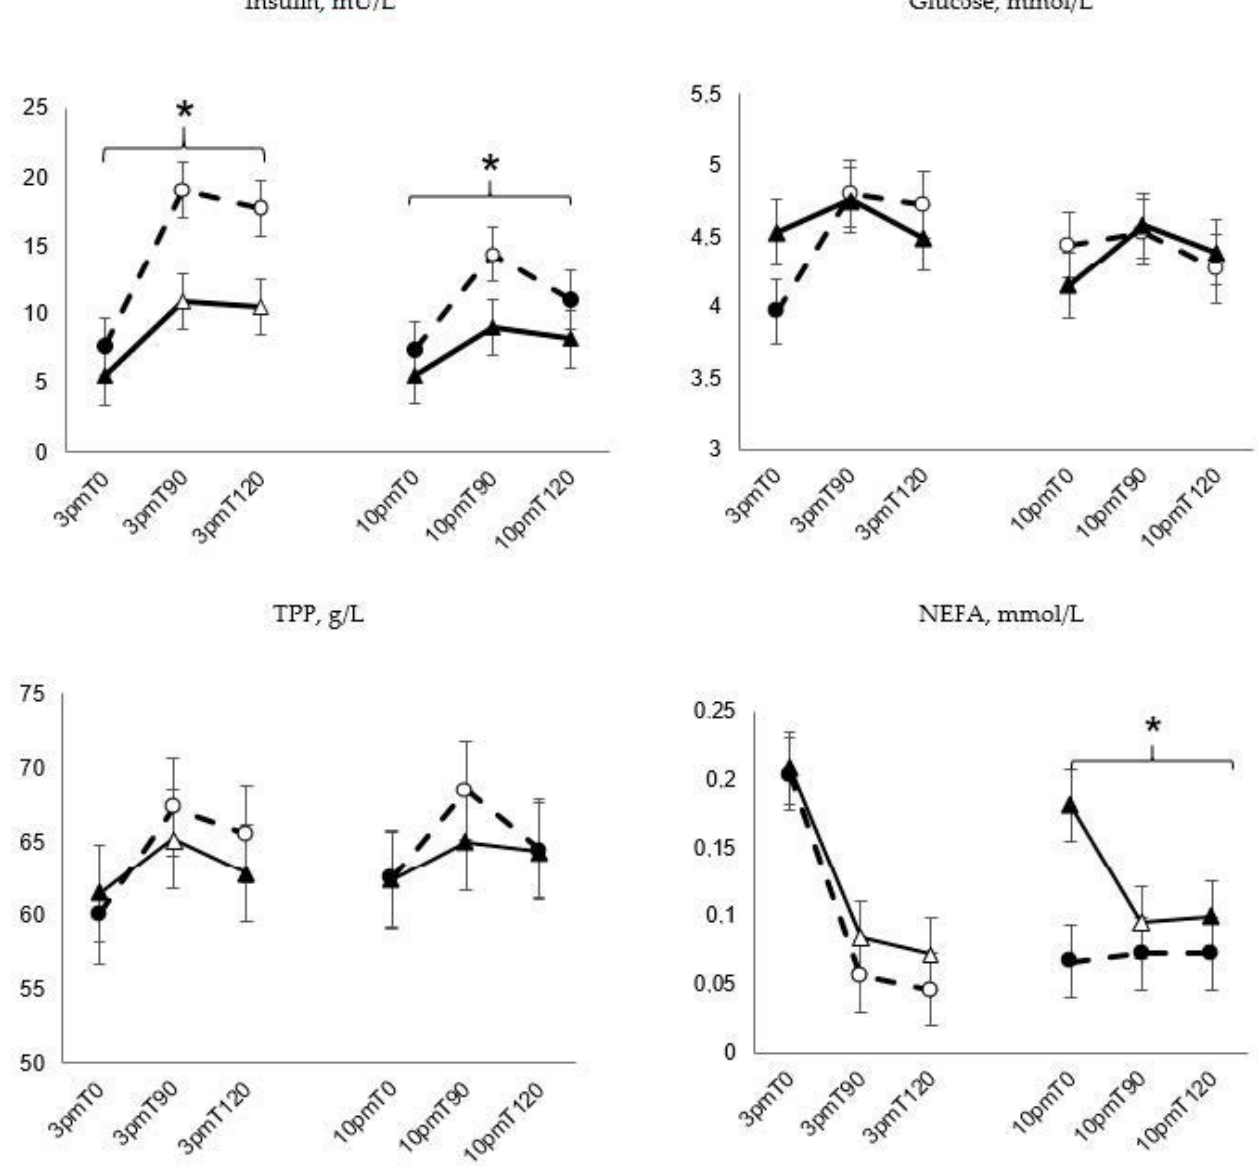
Figure 3. Plasma concentrations of insulin, glucose, NEFA and total plasma proteins (TPP) at time (T) 0, 90 and 120 min after feeding (LSmeans ± SE) in six horses (five horses included in the analysis of plasma insulin and glucose) subjected to a control (grass haylage only) diet ( ● ) and a diet with 50 % wheat straw and 50 % grass haylage (DM basis, ▲ ) in a 2 × 21-day cross-over design. *Indicate an effect of diet within feeding occasion (15.00 feeding and 22.00 feeding, p < 0.05). Unfilled symbols differ from the prefeeding sample (T0) within that feeding occasion ( p < 0.05).